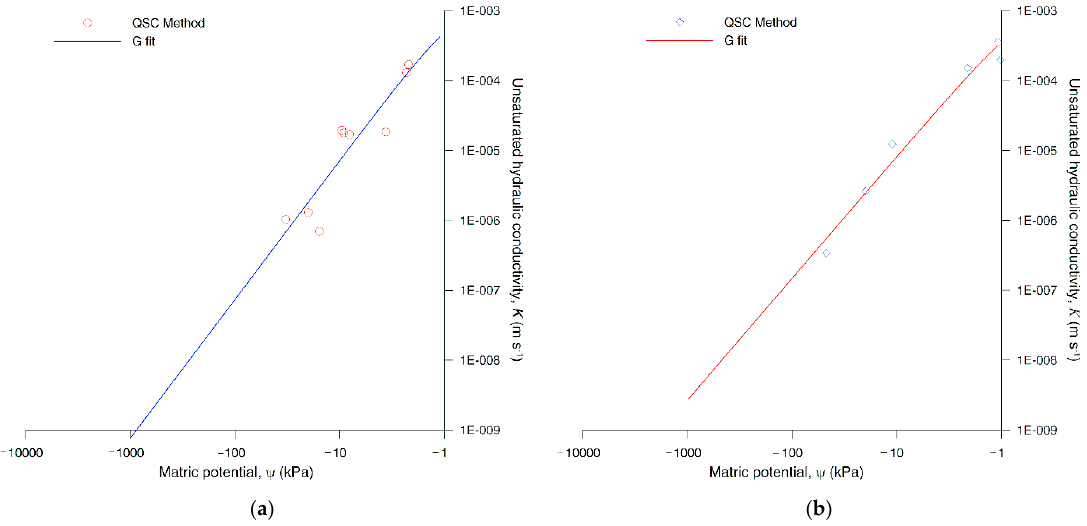
Figure 7. Fitting of measured hydraulic conductivity values with the Gardner model: ( a ) lithotype C; and ( b ) lithotype M.